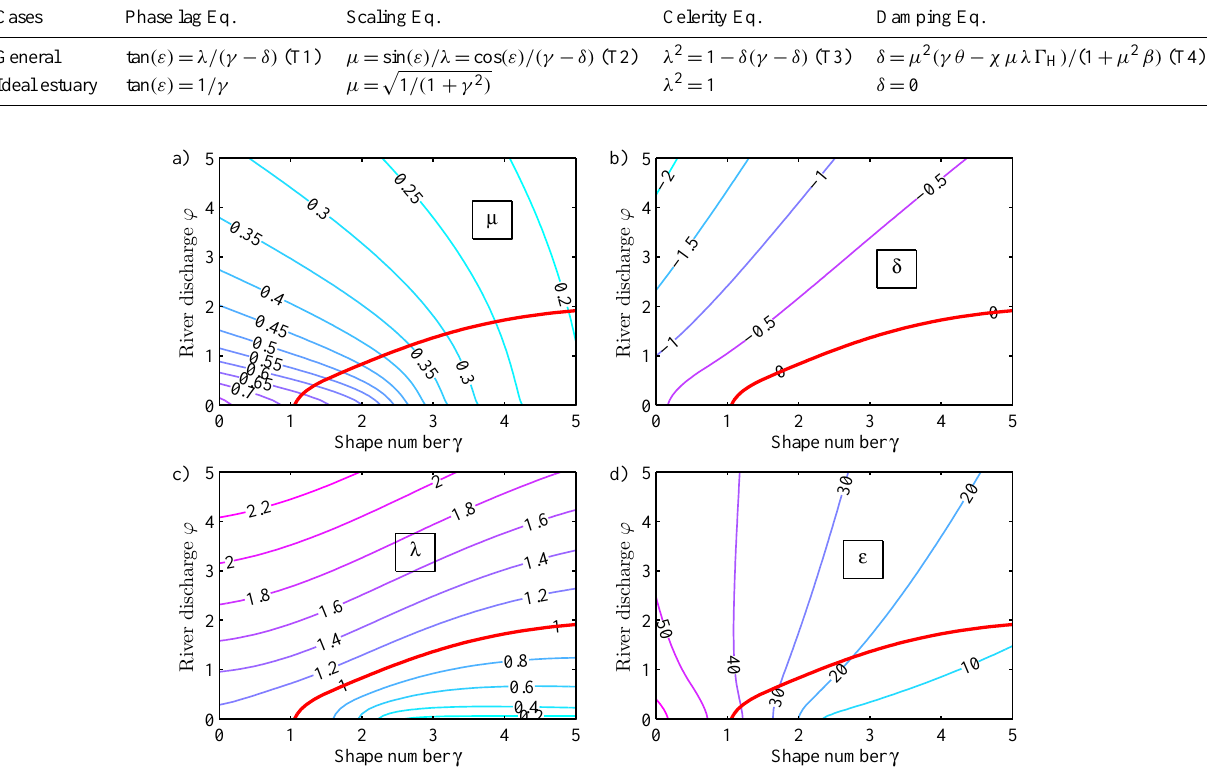
Figure 1. Contour plot of the main dependent parameters – (a) µ , (b) δ , (c) λ , (d) ε – as a function of the estuary shape number γ and the dimensionless river discharge term ϕ obtained by solving Eqs. (T1)–(T4) (see Table 2) for given ζ = 0.1, χ = 2 and r S = 1. The thick red lines represent the ideal estuary, where δ = 0 and λ = 1.